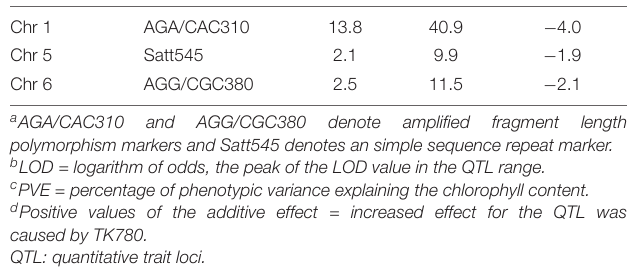
TABLE 1 | QTLs associated with chlorophyll contents in mature seed coats assessed by multiple QTL mapping. Chromosome no.